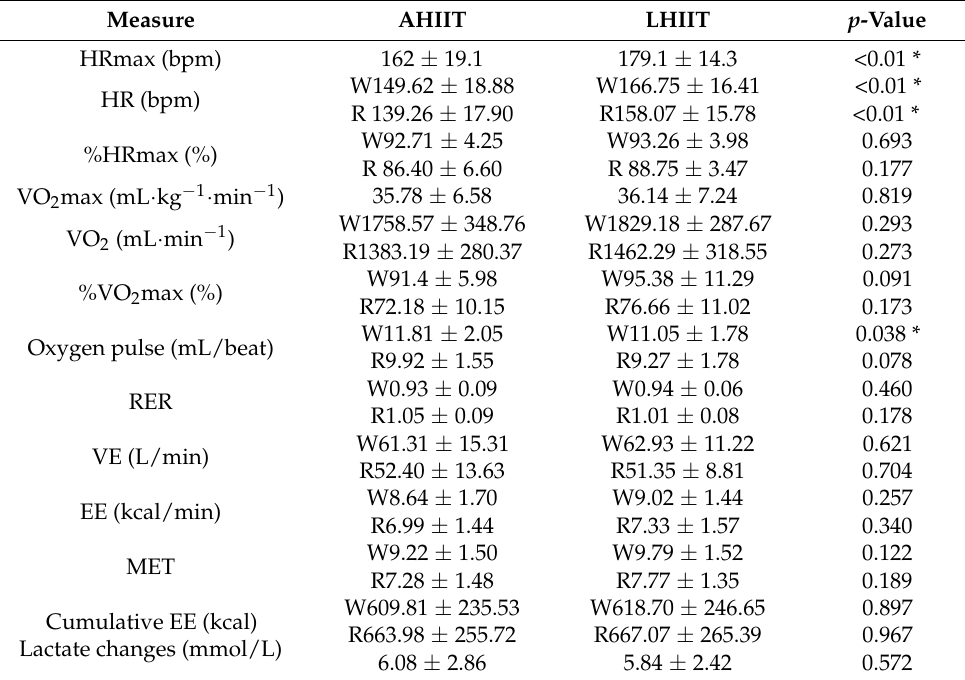
Table 4. Cardiometabolic outcomes in the AHIIT and LHIIT interventions (mean ±